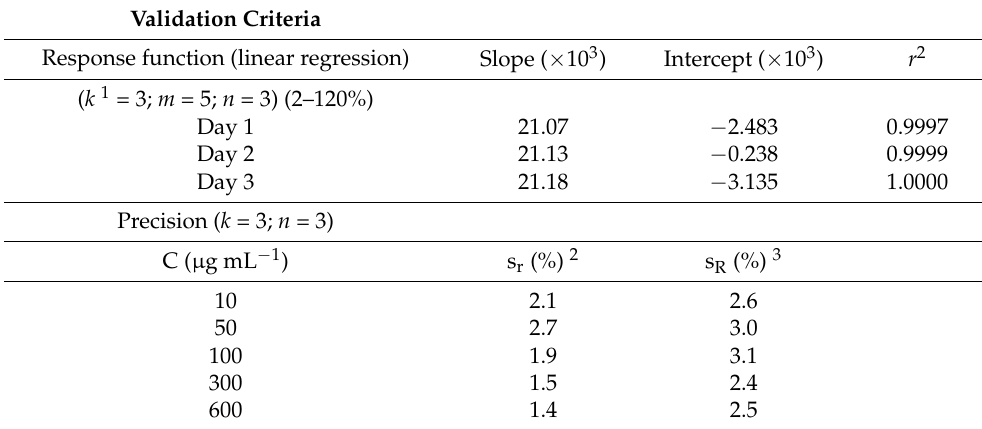
Table 2. Validation results for the determination of PAR in milk-containing biorelevant dissolution samples.